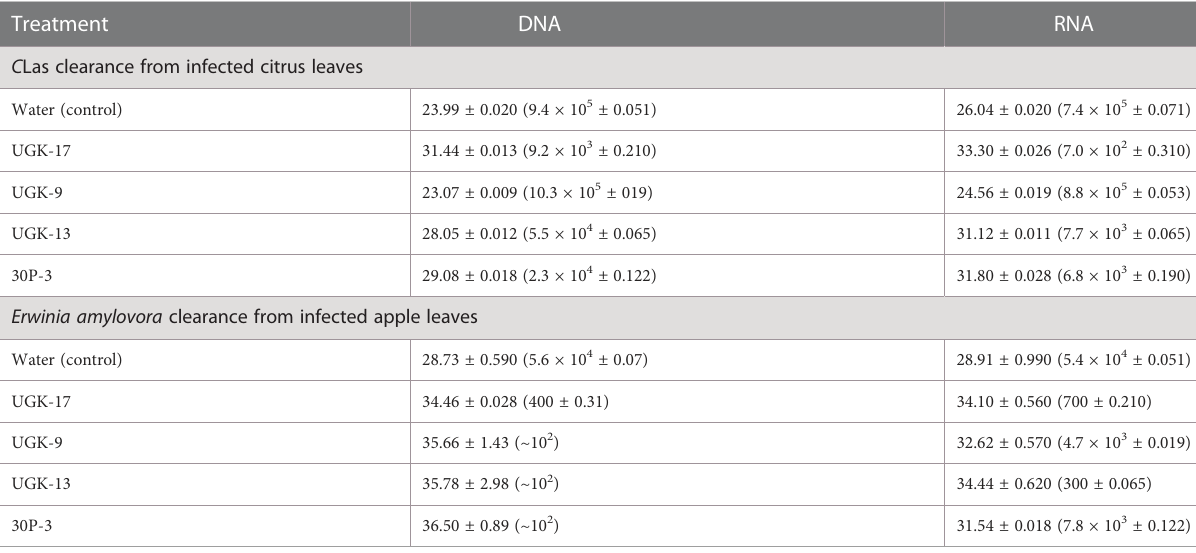
TABLE 4 Data from the detached leaf assay on infected citrus (grapefruit) and apple (Red Delicious) leaves measuring the effect of a 0.8-1ml peptide solution at 25 m M concentration. Treatment DNA